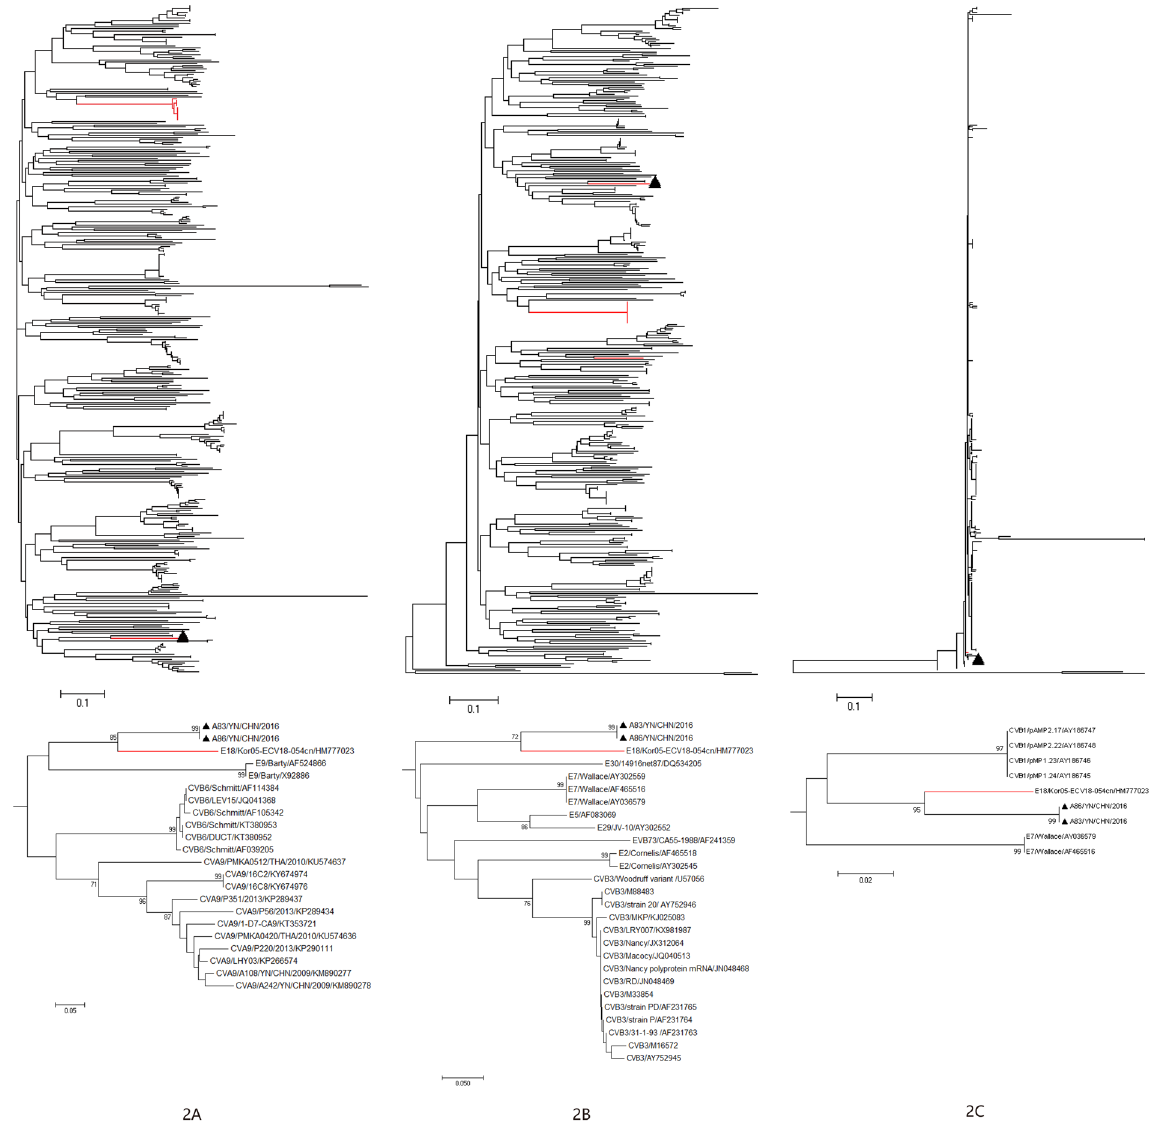
Figure 4. Phylogenetic relationships based on the 2A , 2B , and 2C coding sequences of 379 EV-B strains. Two E-18 strains and 377 EV-B strains available in GenBank database were analysed by nucleotide sequence alignment using the neighbor joining algorithms implemented in the MEGA 6.06 program. Numbers at the nodes indicate bootstrap support for that node (percentage of 1000 bootstrap replicates). The scale bars represent the genetic distance. Only high bootstrap values ( > 75%) are shown. Only high bootstrap values ( > 75%) are shown. ▲ Strains isolated in this investigation. Red denote the other E-18